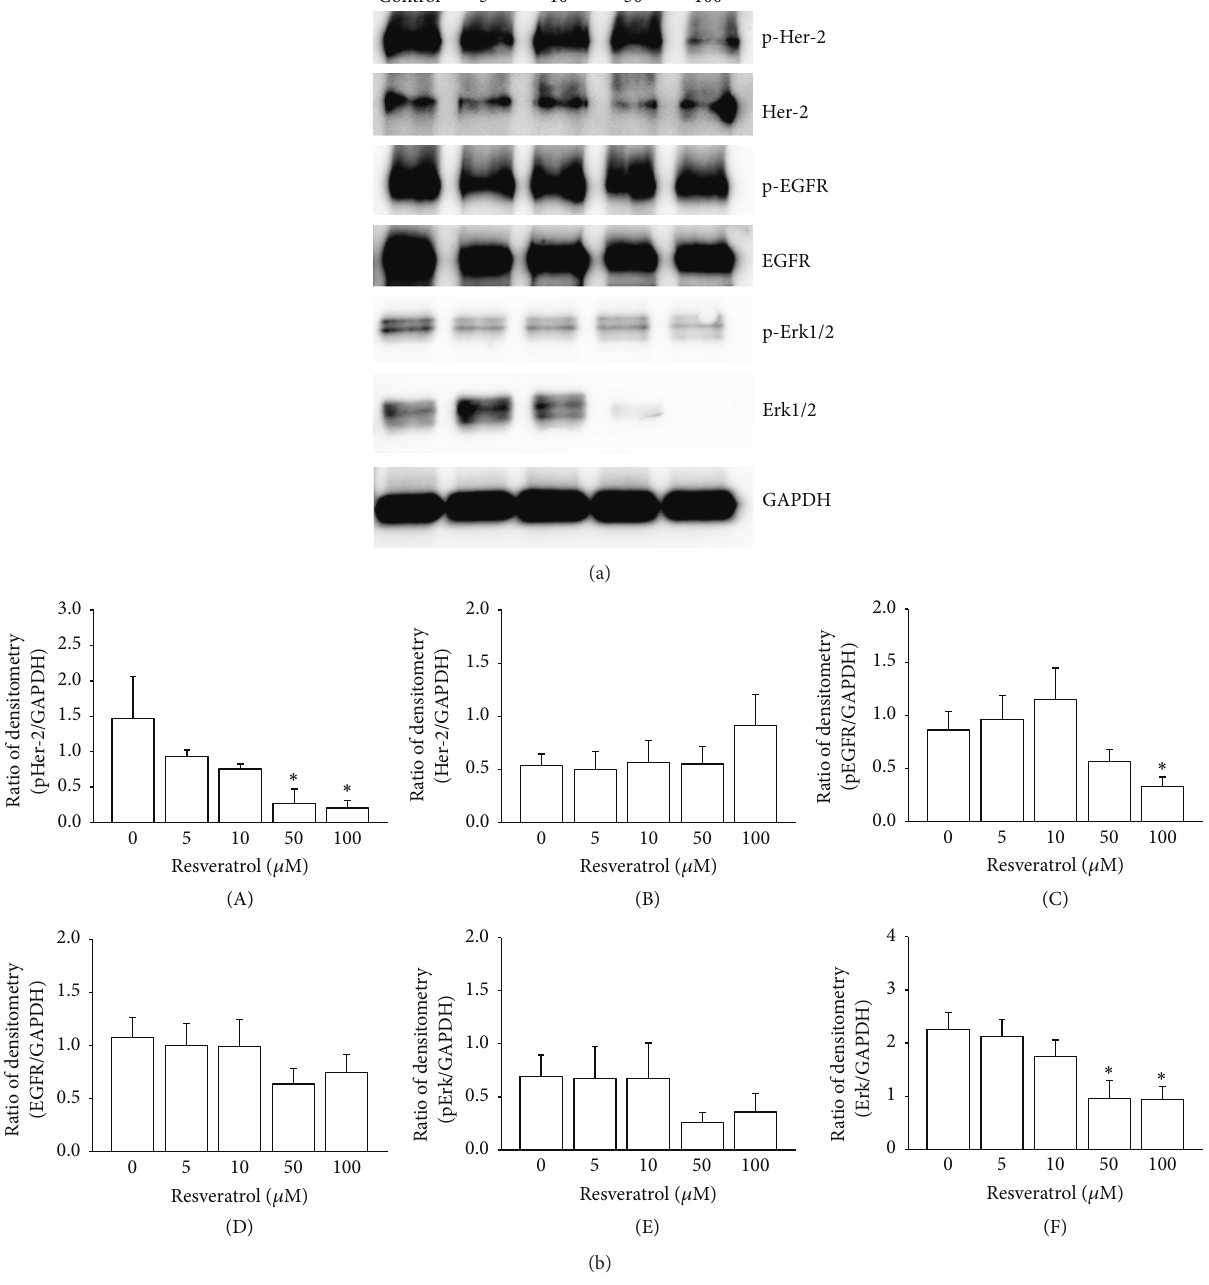
Figure 4: The expression and phosphorylation of Her-2, EGFR, Erk1/2, and GAPDH in SKOV-3 cell aggregates after treatment with resveratrol. Higher concentrations of resveratrol reduced the phosphorylation of Her-2 (A) and EGFR (C) and total expression of Erk1/2 (F). ∗ refers to statistically significant as 𝑝 value less than 0.05 compared to the control.